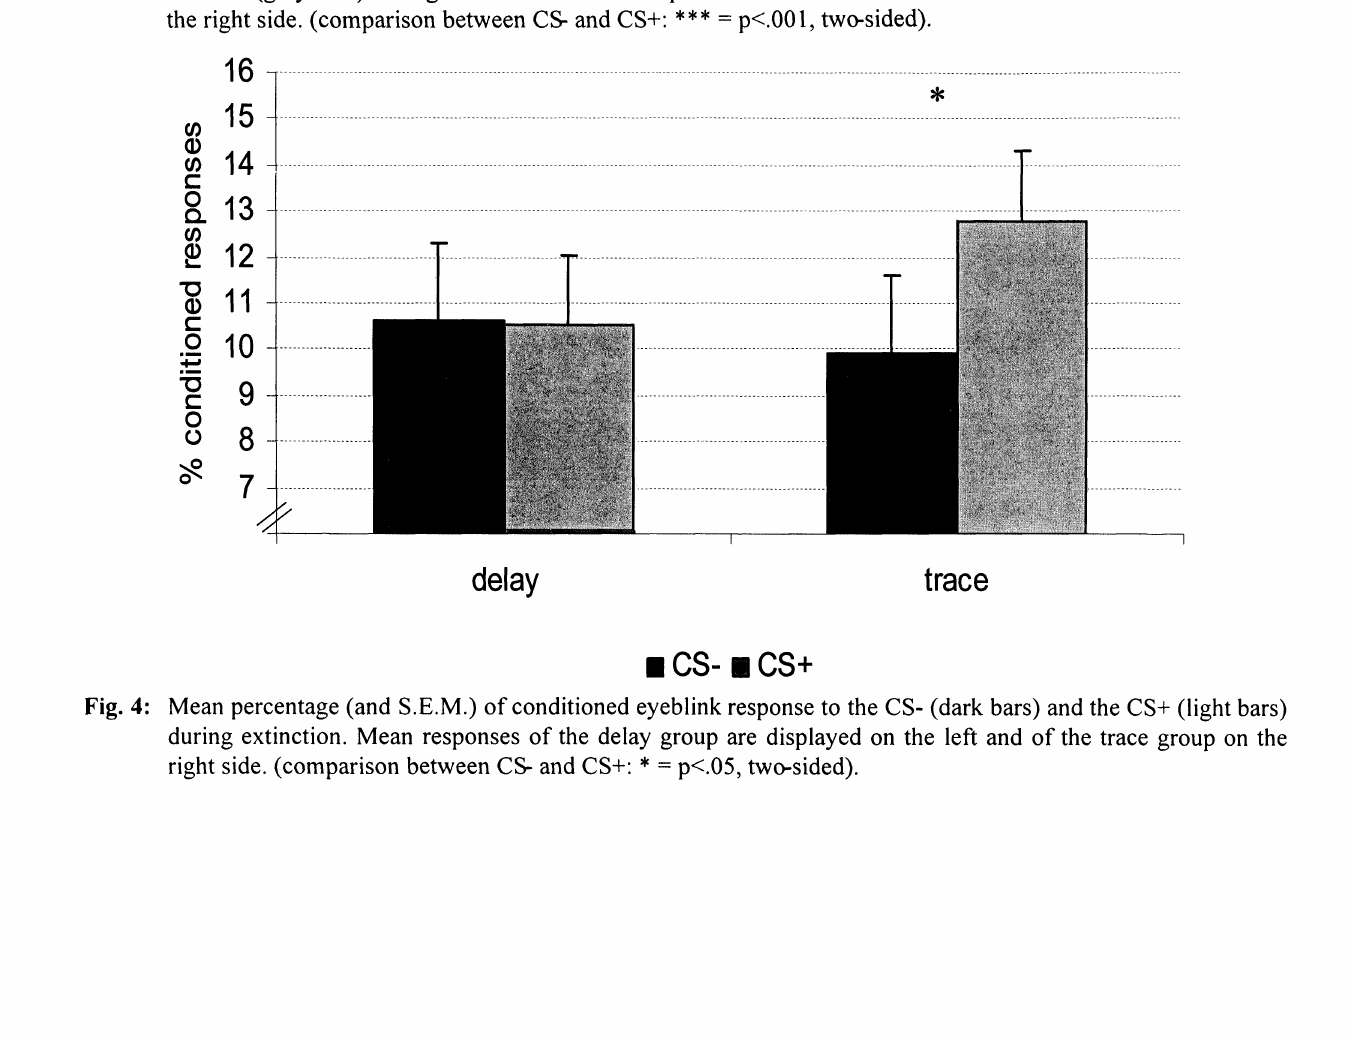
Fig. 3" Mean percentage (and S.E.M.) of conditioned eyeblink response from all subjects to the CS- (black bars) and the CS+ (gray bars) during the last 50 trials of acquisition on the left side and the first 50 trials of extinction on the right side. (comparison between CS- and CS+: *** p<.001, two-sided).